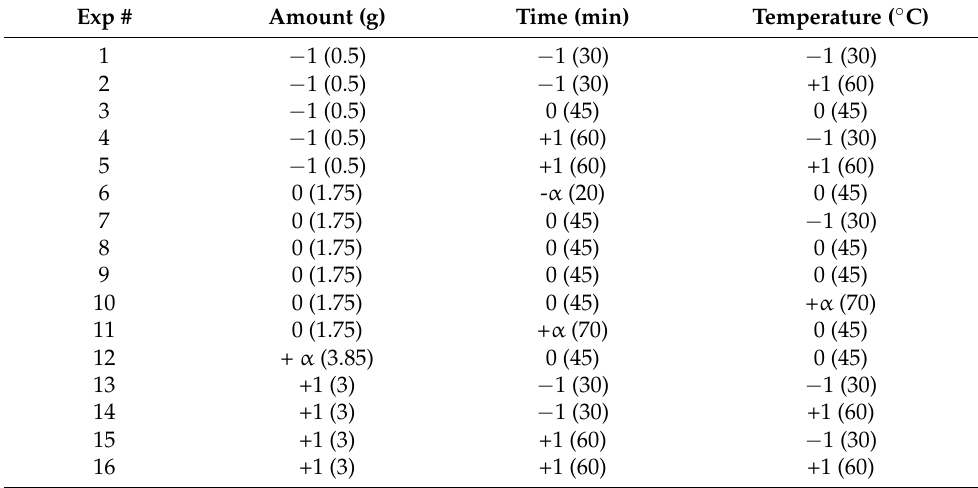
Table 2. Planning of experiments by CCD